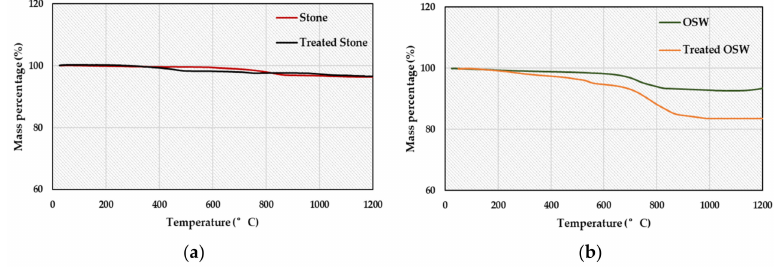
Figure 12. TGA curves of treated and untreated OSW and stone. ( a ) TGA curves of treated and untreated Stone; ( b ) TGA curves of treated and untreated